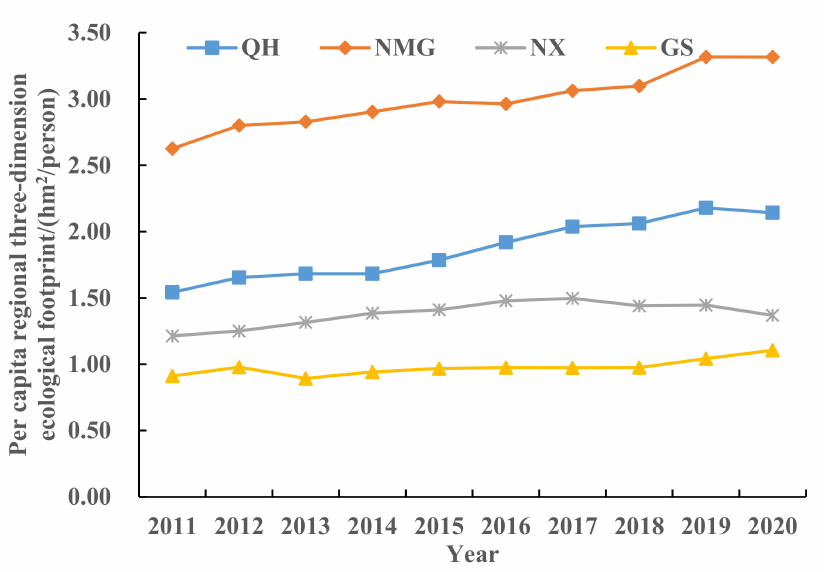
Figure 5. Changes of per capita regional three-dimensional ecological footprint in the upper reaches of the Yellow River from 2011 to